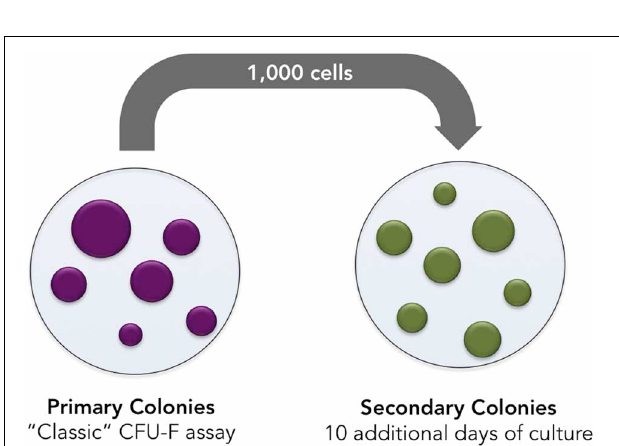
(B) , bone marrow cells are incubated in culture medium supplemented with testing serum. After 72h, non-adherent cells are discarded and adherent cells are culture for 10 additional days in culture medium supplemented with control FBS. Colony numbers and size must be evaluated.